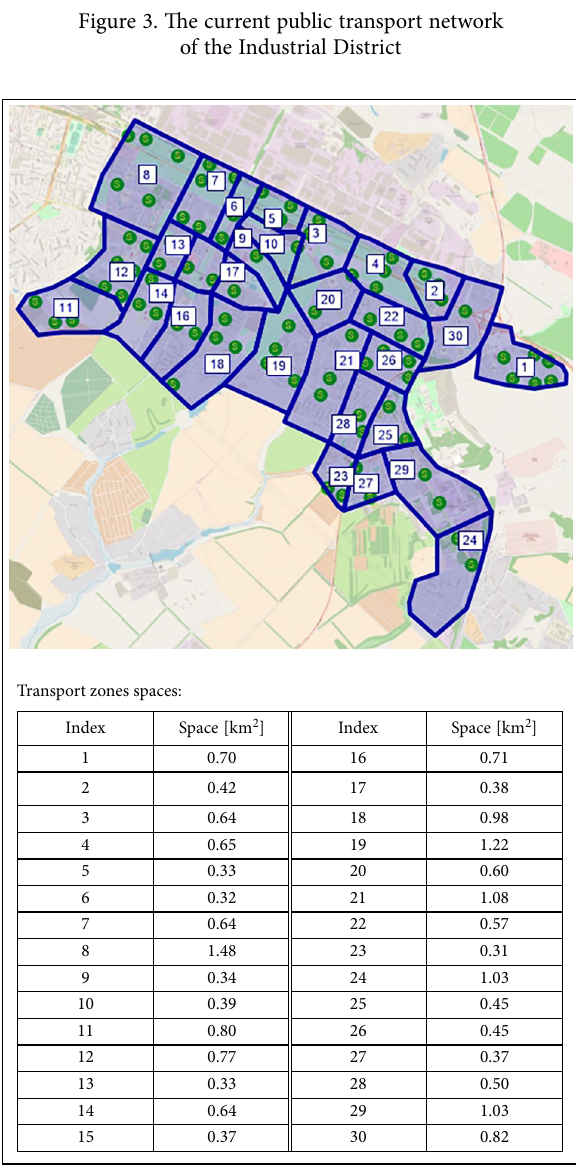
Figure 4. Results of transport zones formation